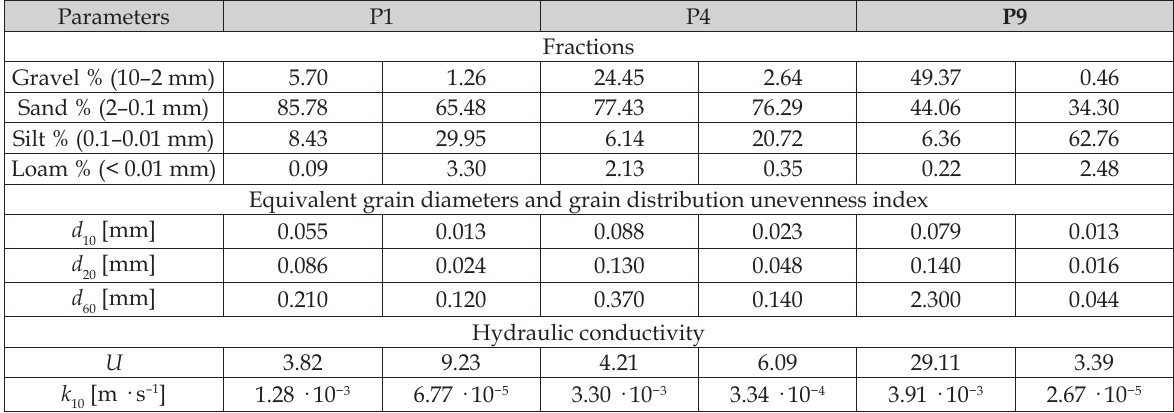
Table 3. Granulometric and hydraulic characteristics of the Moszczenica riverbed sediments.